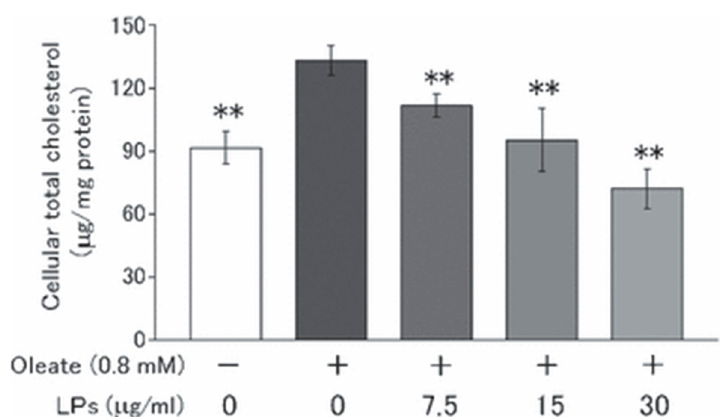
Figure 3. Effect of Lignophenols (LPs) on the amount of cellular total cholesterol in HepG2 cells incubated for 48 h in serum-free media containing different concentrations of LPS. The differences between means were significant at ** p < 0.01, compared with oleate-treated cultures (Reprinted with permission from